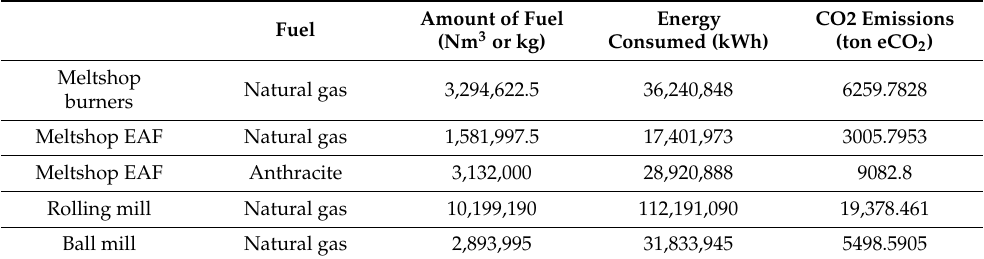
Table 4. Values for the energy efficient solution